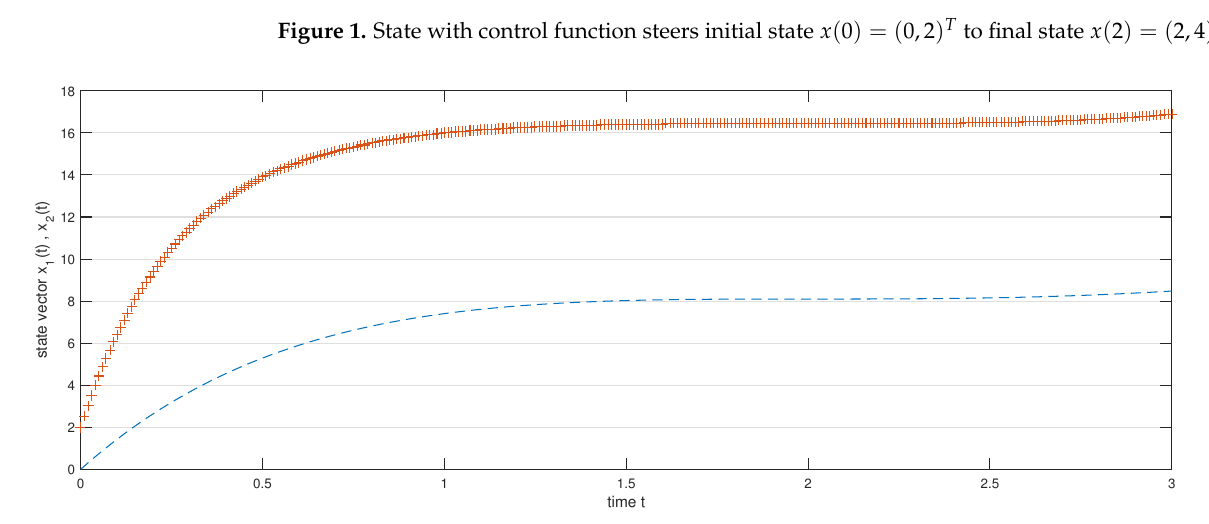
Figure 2. State vectors without control function.